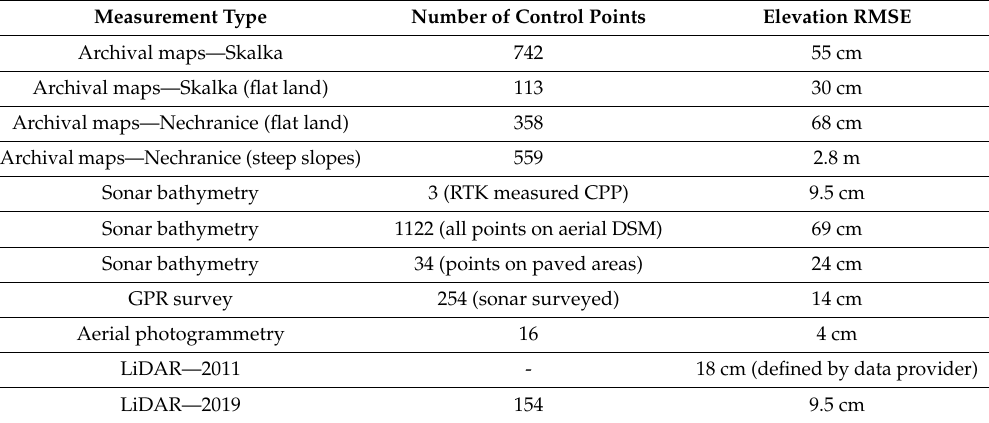
Table 1. Quality evaluation of selected methods. DSM: digital surface model, RMSE: root mean square